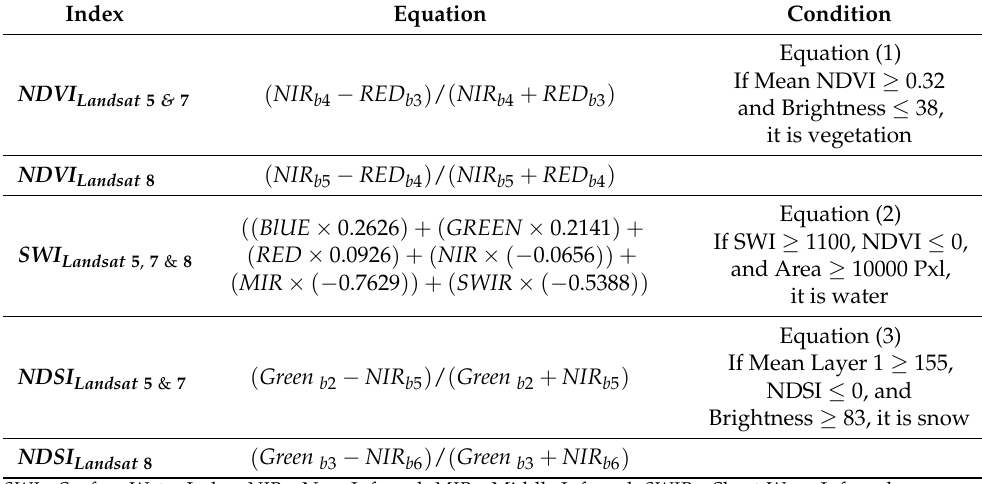
Table 1. A set of equations applied when implementing dynamic rule-based